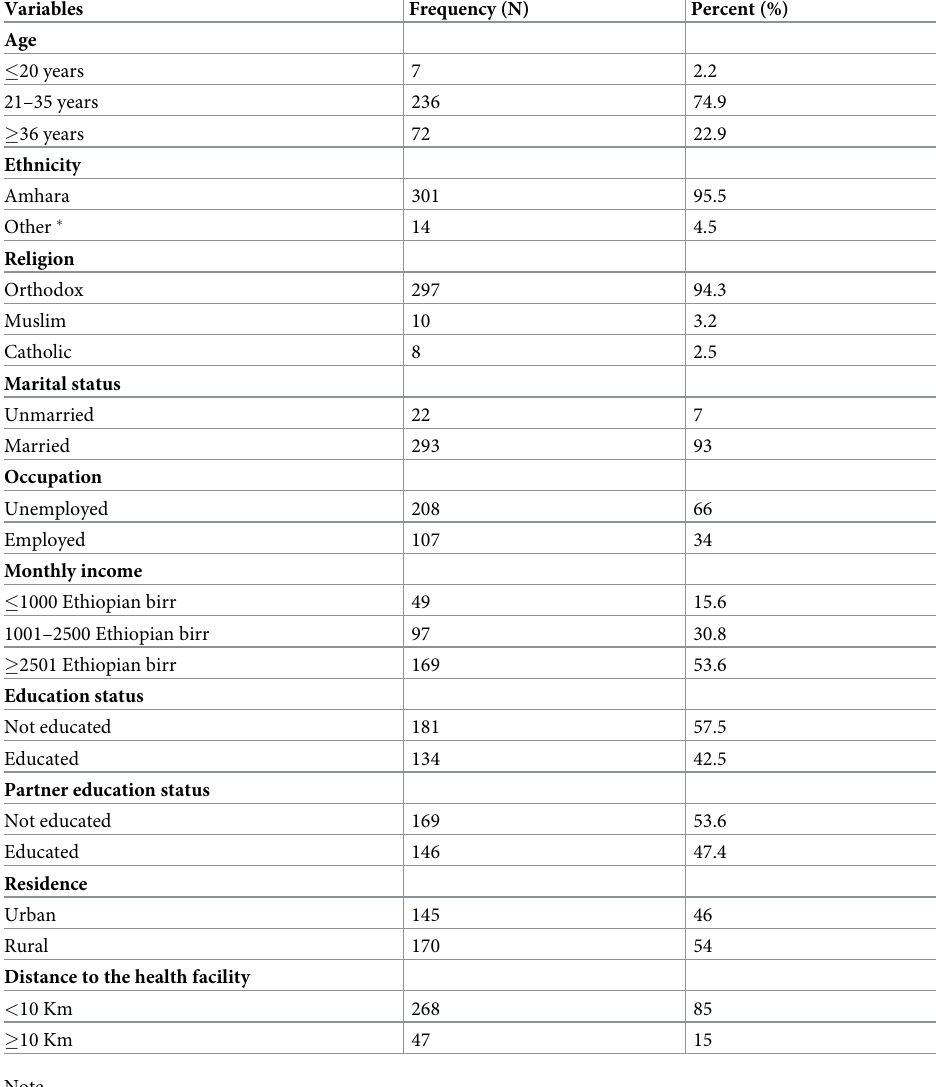
Table 1. Socio-demographic and economic characteristics of PROM and associated factors among pregnant women admitted to the maternity ward at Debre Markos Referral Hospital, 2019.